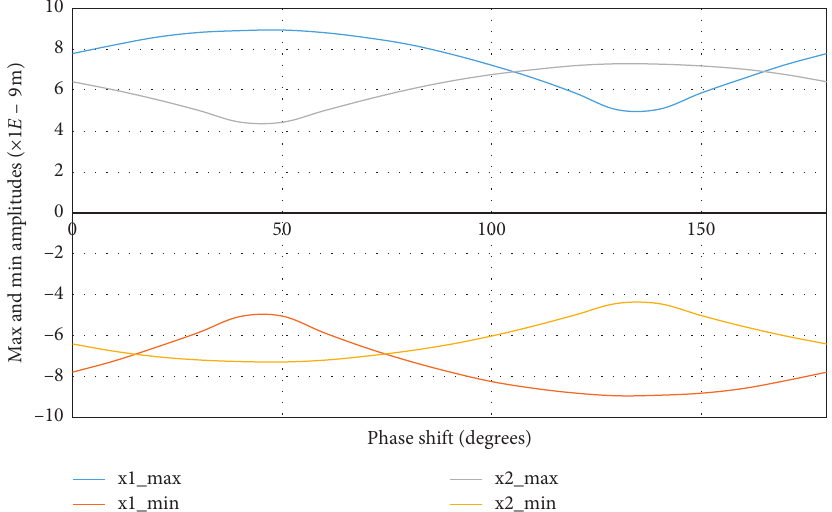
Figure 20: Effects of phase shift on the maximum and minimum amplitude values of x